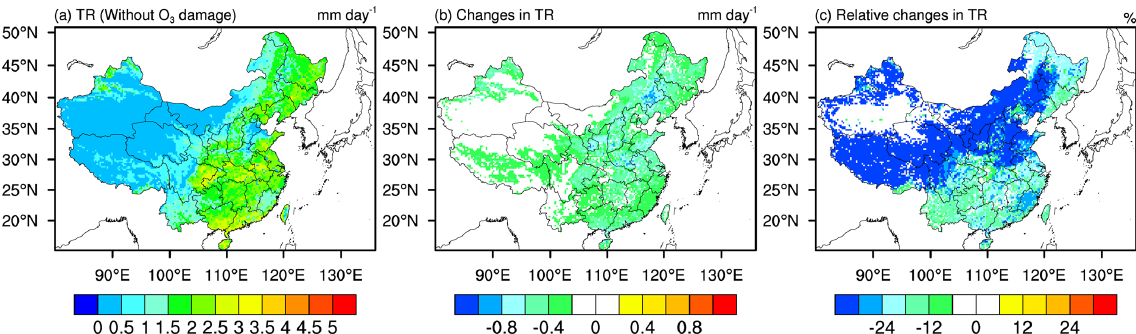
Figure 5. Spatial distribution of 2014–2017 JJA mean (a) transpiration rate (TR), and (b) absolute changes and (c) relative changes in TR caused by O 3